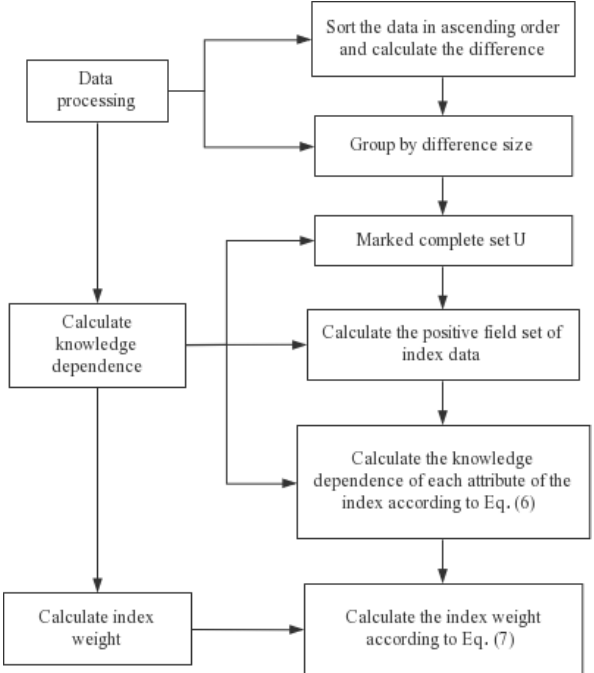
Figure 3. Flow chart of the objective weight calculation algorithm according to knowledge